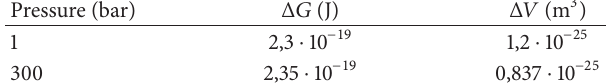
Table 2: Parameters of Crine’s model for the ageing of XLPE at 70 ∘ C. Pressure (bar)